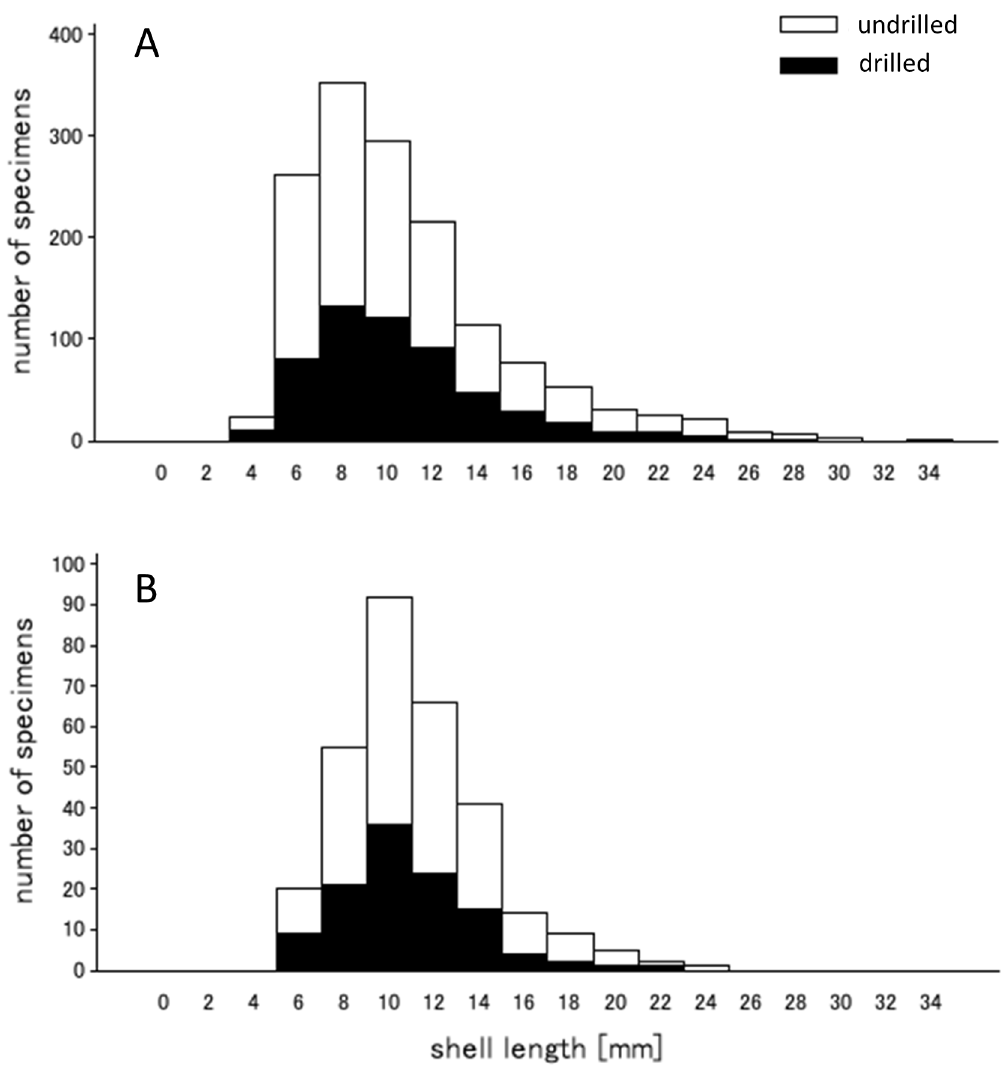
Figure 5. Size-frequency distributions of shells of Chamelea gallina from August transects. Drilled and undrilled specimens are differentiated. (a) Data for 1978–1981 time interval; (b) Data for 2008–2010 time interval.